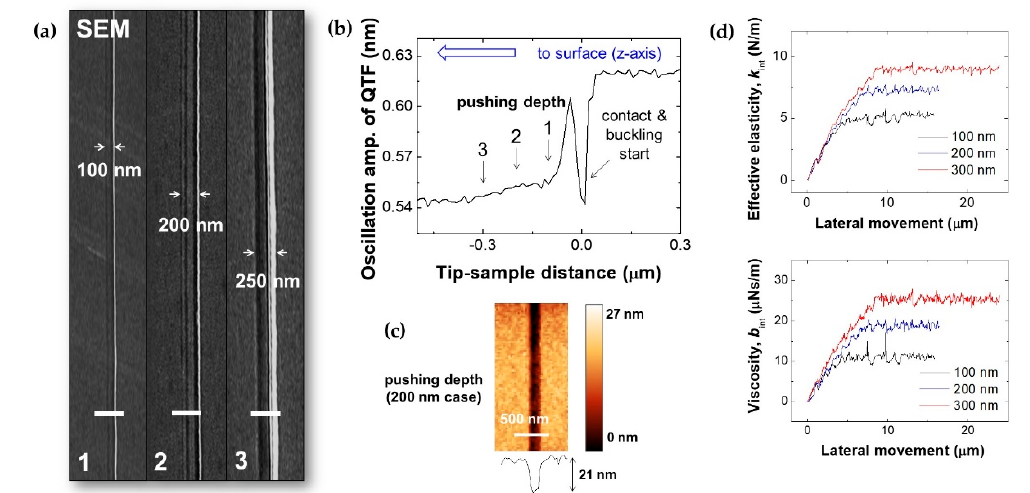
Figure 7. Nanoscratching via nanorod / QTF–AFM: ( a ) SEM images of the scratched linewidths with ~100 nm (1), ~200 nm (2), and ~250 nm (3); ( b ) amplitude approach curve of QTF sensor ( z -axis) for definition of pushing depth; ( c ) AFM images and depth profiles (trench depth: 25 nm) for pushing depth of 200 nm; ( d ) detected k int and b int by lateral motion according to pushing depth (100–300